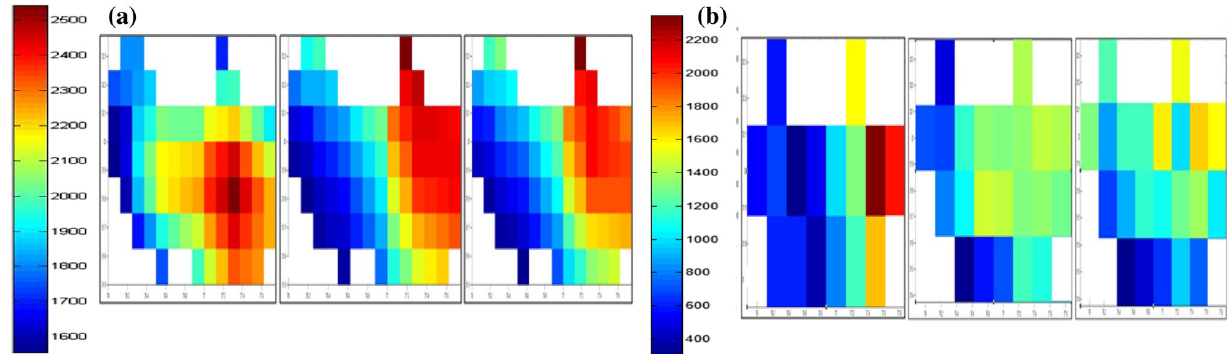
Fig. 5 Spatial variation of a ERA-Interim and b IMD rainfall during monsoon (June–September), post-monsoon (October–January) and pre- monsoon (February–May) Fig. 6 Observed rainfall data from rain gauge station of Beas river basin of a Pong dam and b Pandoh